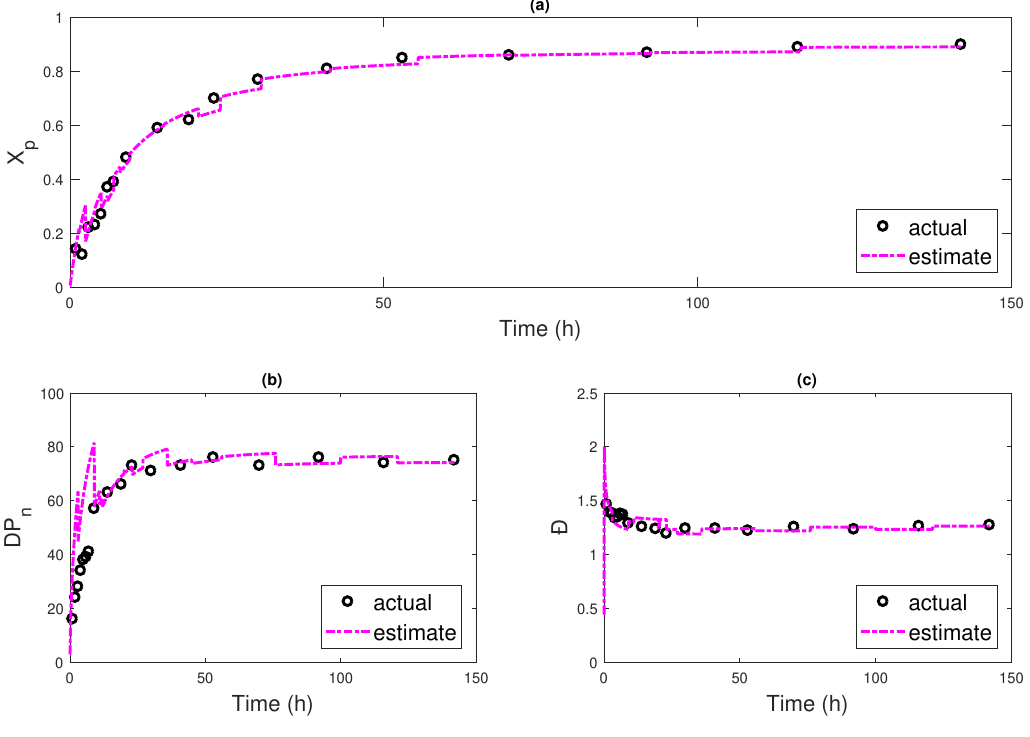
Figure 9. Observer performance based on experimental data for ( a ) monomer conversion X p ; ( b ) number average molecular weight DP n ; ( c ) dispersity Ð